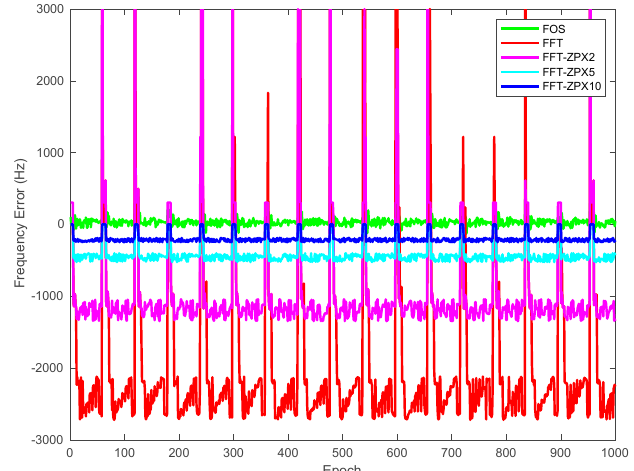
Figure 10. Estimated swept jamming signal frequency errors using the proposed method, FFT, and zero-padding FFT-based anti-jamming algorithms.